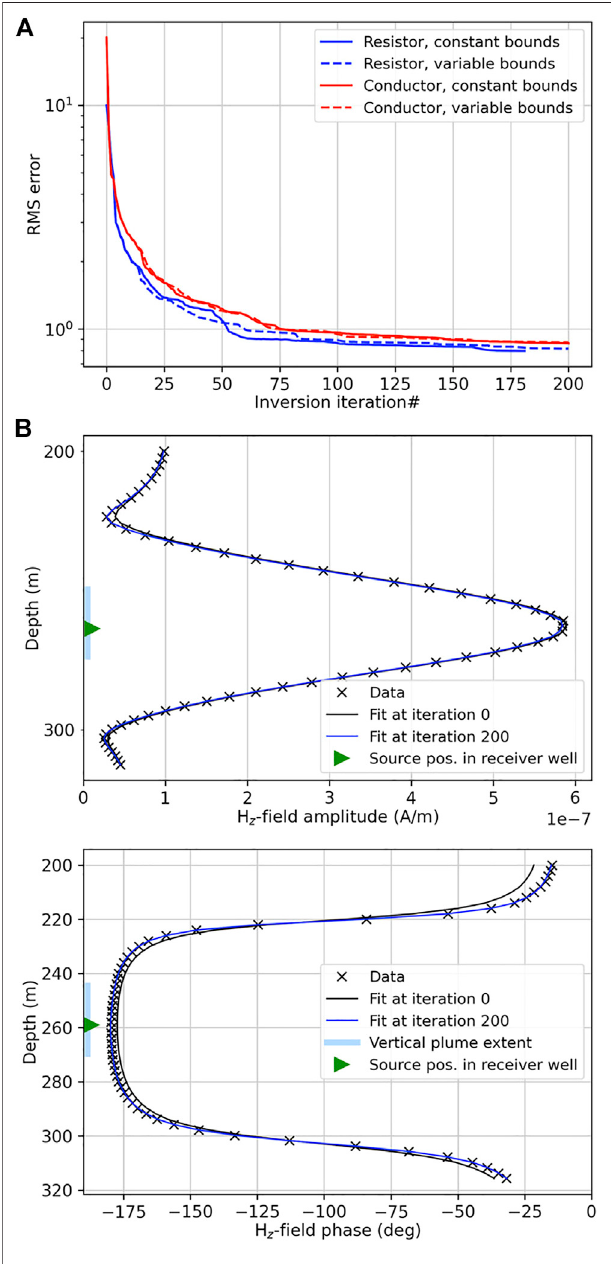
FIGURE 7 | (A) : Total RMS mis fi t for four synthetic-data inversions for a resistive and conductive plume, each comparing constant versus variable bounds. (B) : Inverted data (symbols) and fi ts for the initial model guess (iteration 0) and the fi nal model update (iteration 200) are shown as amplitudes and phases calculated from the vertical magnetic fi eld. The shown pro fi lecorrespondstoonetransmitter-receivertraversewithitssourcelocated at z = 259 m. The vertical blue bar (left) indicates the vertical extent of the ellipsoidal plume.